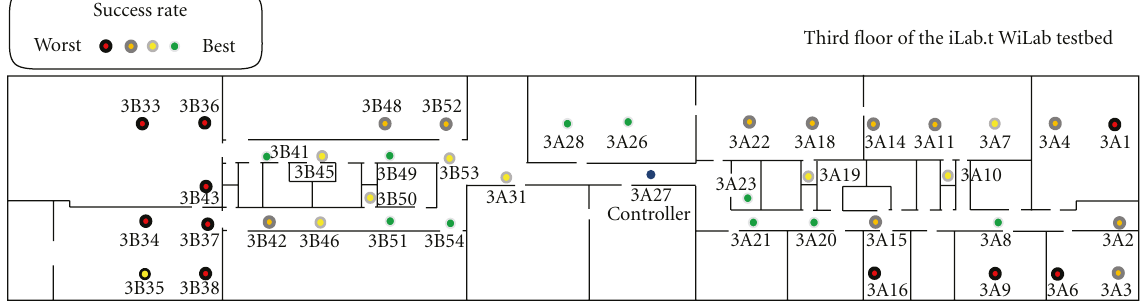
Figure 12: Spatial distribution of the individual success rate on the third floor of the iLab.t WiLab testbed. 4 categories: green = best, yellow, orange, and red (worst). The blue node is the controller.